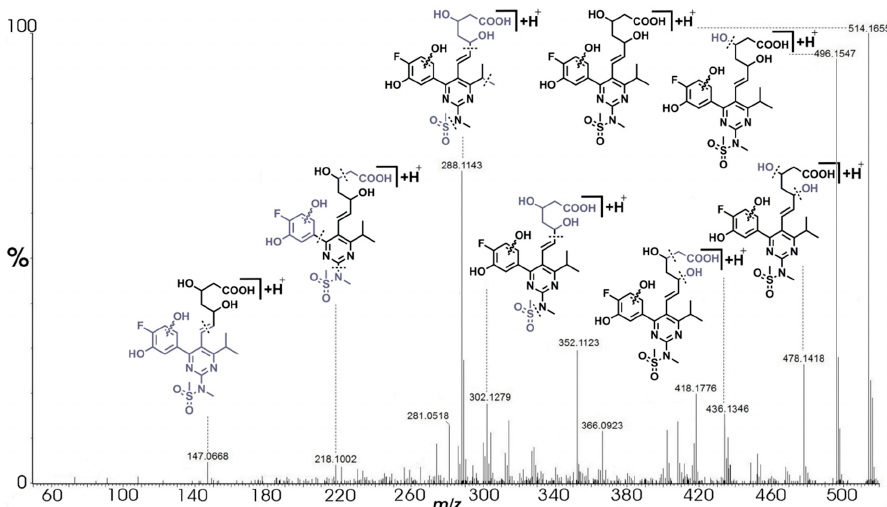
Figure 7. Fragmentation MS/MS spectra of product D.1 [M + H] + ion (precursor ion m/z 514.1655) obtained by using collision energy of 25 V.